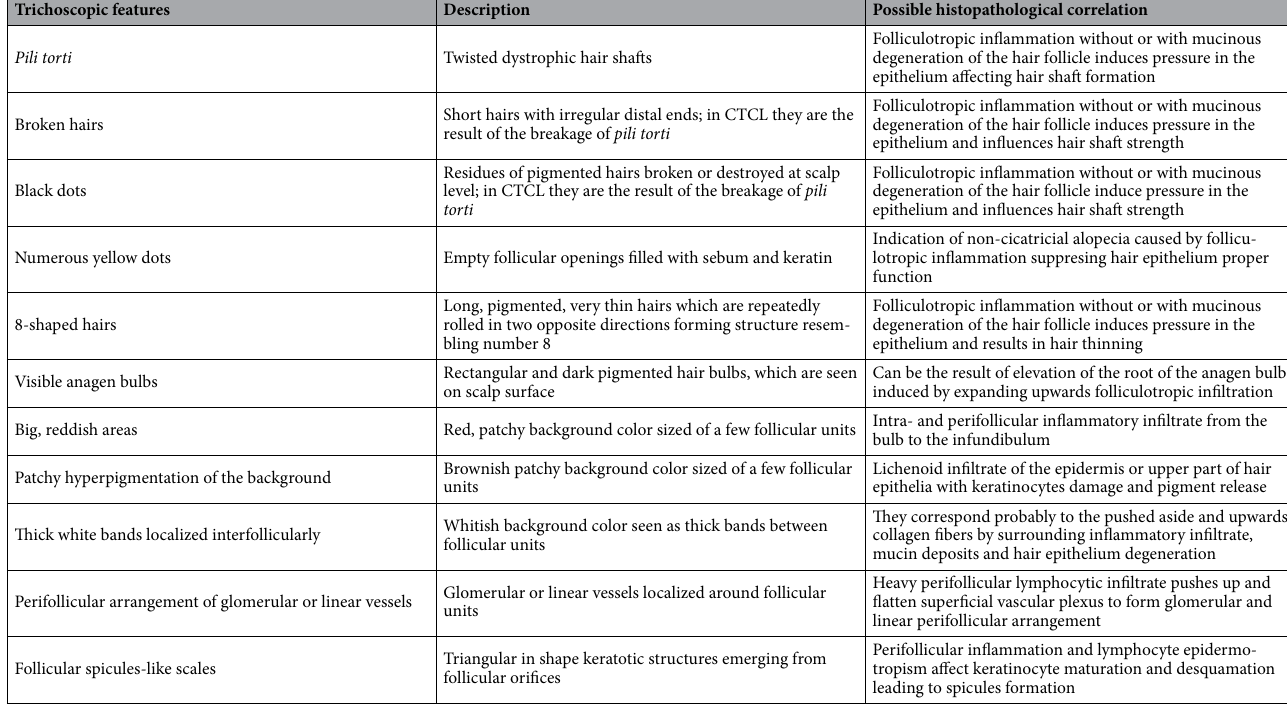
Table 5. Description of trichoscopic findings in erythrodermic cutaneous T-cell lymphoma (CTCL) with histopathological